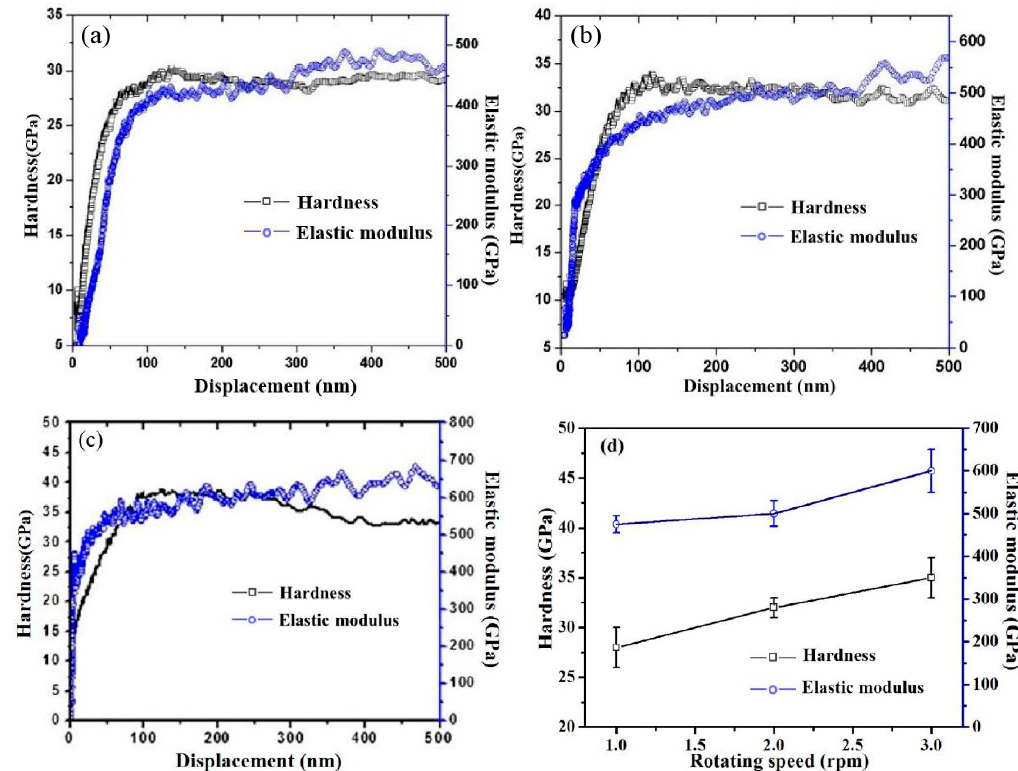
Figure 6. Nanohardness and Young’s modulus versus the displacement for Mo-Ti-Al-N coatings fabricated at different rotating speeds: 1 rpm ( a ), 2 rpm ( b ), and 3 rpm ( c ). In panel ( d ), the mean values of both factors are shown versus the rotating speeds.